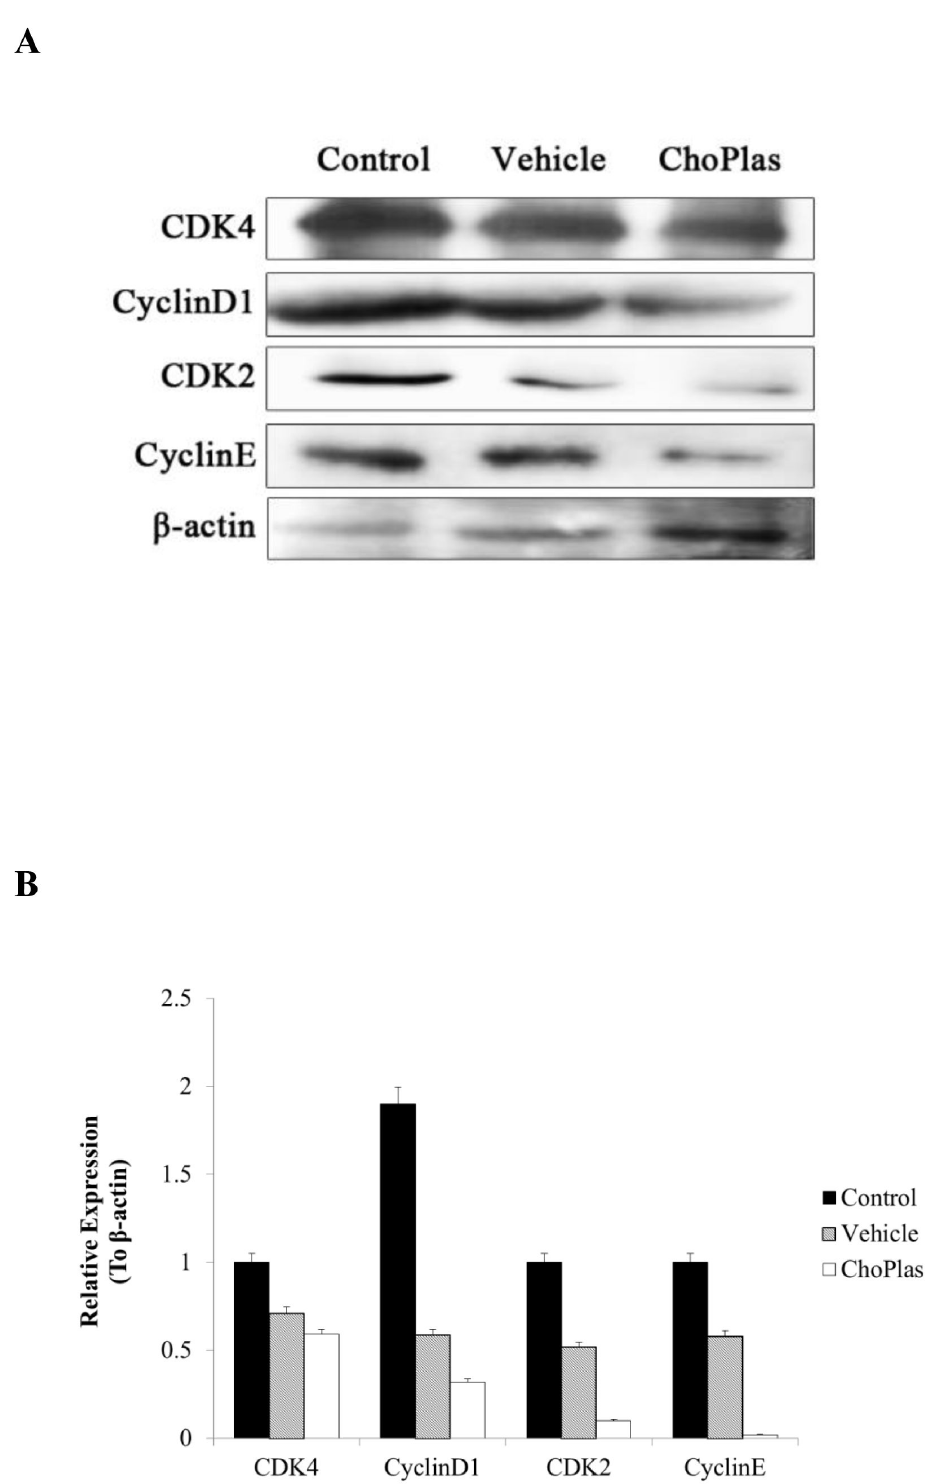
Figure 7. Cell cycle regulator protein expression following ChoPlas treatment. CBRH7919 cells were treated with 25 μmol/L ChoPlas for 24 h and then harvested. (A) Total protein was extracted and then blotted with Cyclin D1, CDK4, Cyclin E and CDK2 antibodies; (B) Graph depicting the semi-quantization of Cyclin D1, CDK4, Cyclin E and CDK2 expression computed using Image J software. Data are presented as the mean±S.D (n=3). doi: 10.1371/journal.pone.0077387.g007 PLOS ONE |